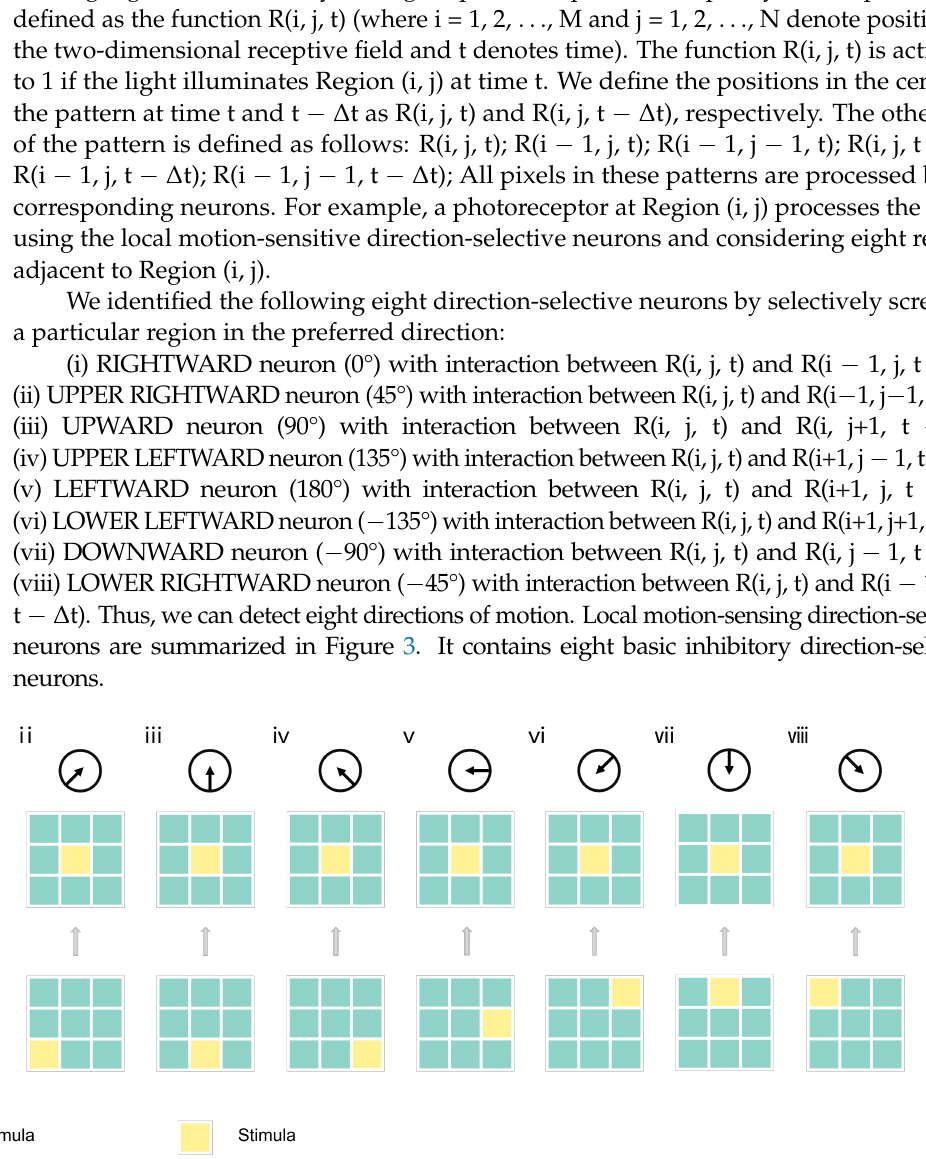
Figure 3. The local directionally detective neurons ( i ) Rightward, ( ii ) Upper Rightward, ( iii ) Upward, ( iv ) Upper Leftward, ( v ) Leftward, ( vi ) Lower Leftward, ( vii ) Downward, ( viii ) Lower